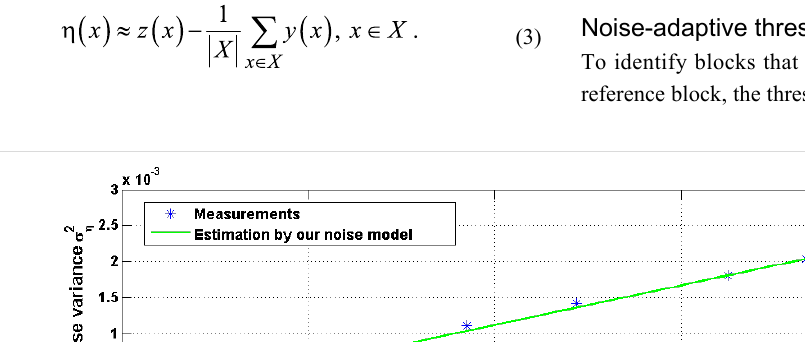
(AWGN), which is independent of the signal. A more generic noise model of the form: